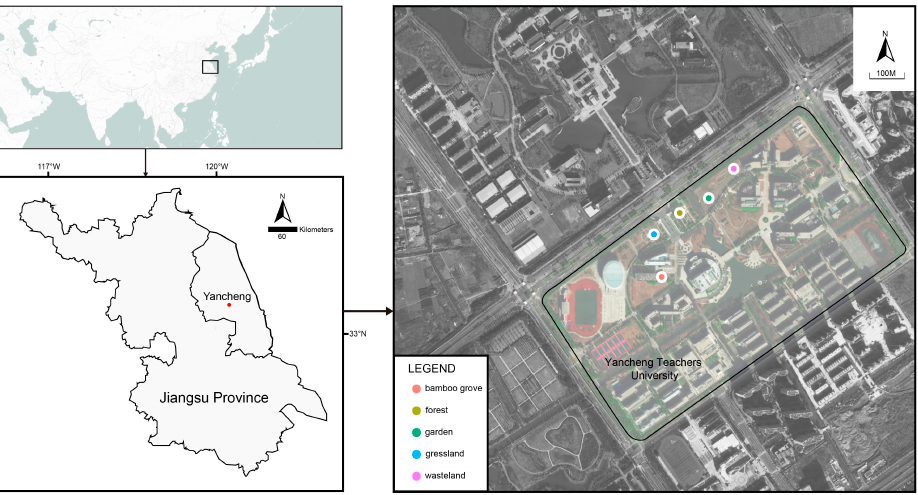
Figure 1. Study area and sampling site of Yancheng City, Jiangsu Province.